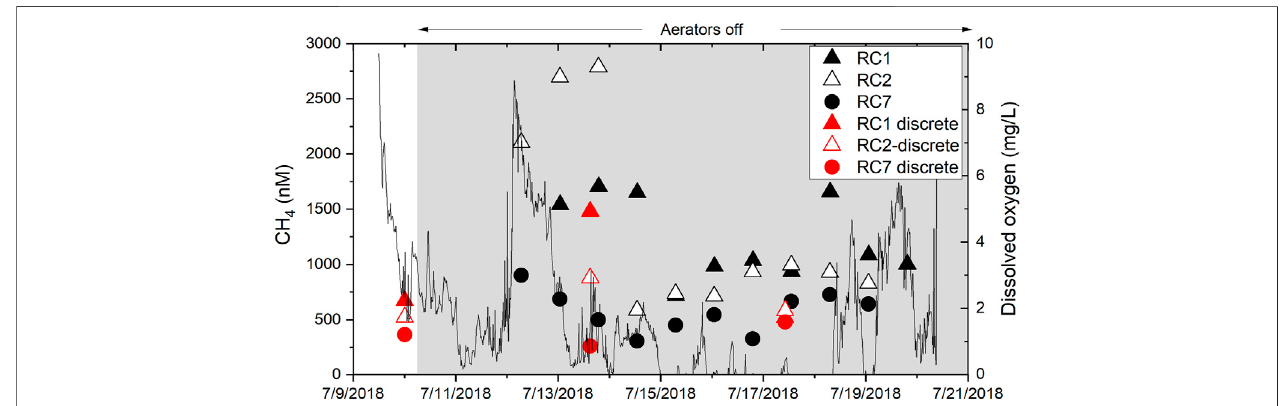
FIGURE10| Methane concentrationsin high temporal resolutionin bottom water from fast OsmoSamplers(blackand whitesymbols) and discrete watersamples (red symbols) in 2018 from stations RC1 ( fi lled stars), RC2 (open stars), and RC7 ( fi lled circles). Discrete samples overlap with OsmoSampler concentrations. Thin black line shows a dissolved oxygen record from sensors deployed in the bottom water off a nearby dock.